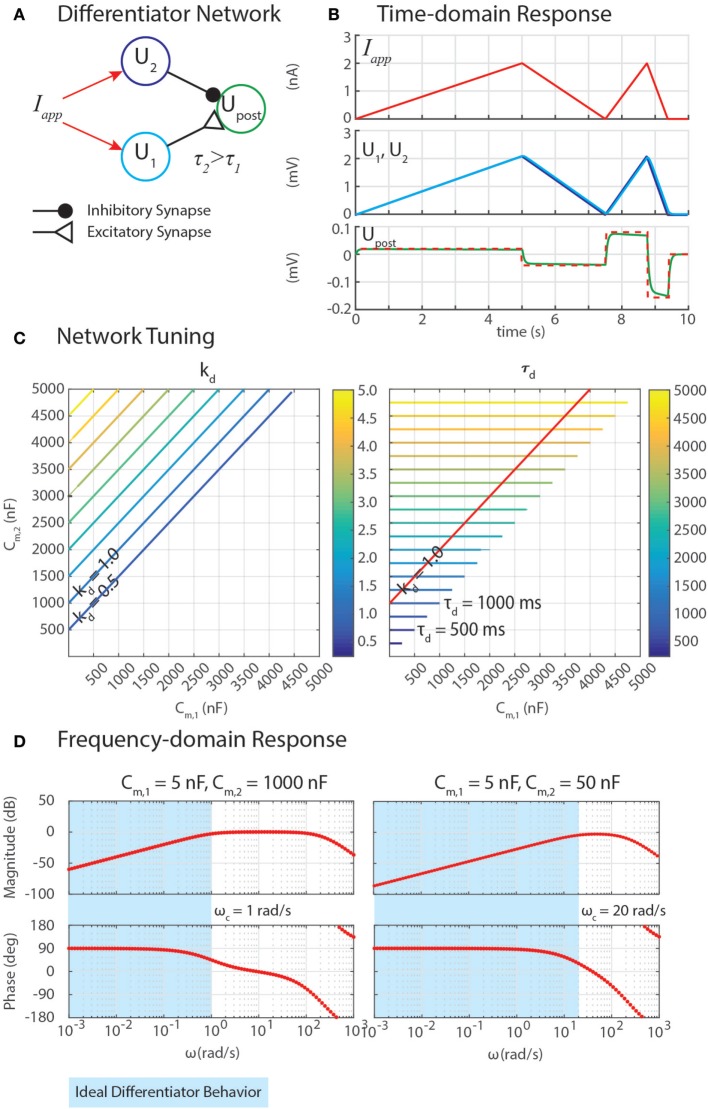
(A) A network can exploit neural dynamics to compute the differential of an incoming signal. (B) When given an applied current in the form of ramps, the network returns steps whose heights are proportional to the slopes of the ramps. (C) The amplification of the differential, kd, and the time constant of the network, τd, depend on the capacitance of the neurons, Cm,1 and Cm,2. (D) Frequency domain analysis enables the identification of the cutoff frequency ωc, enabling the network to naturally filter out high-frequency noise.